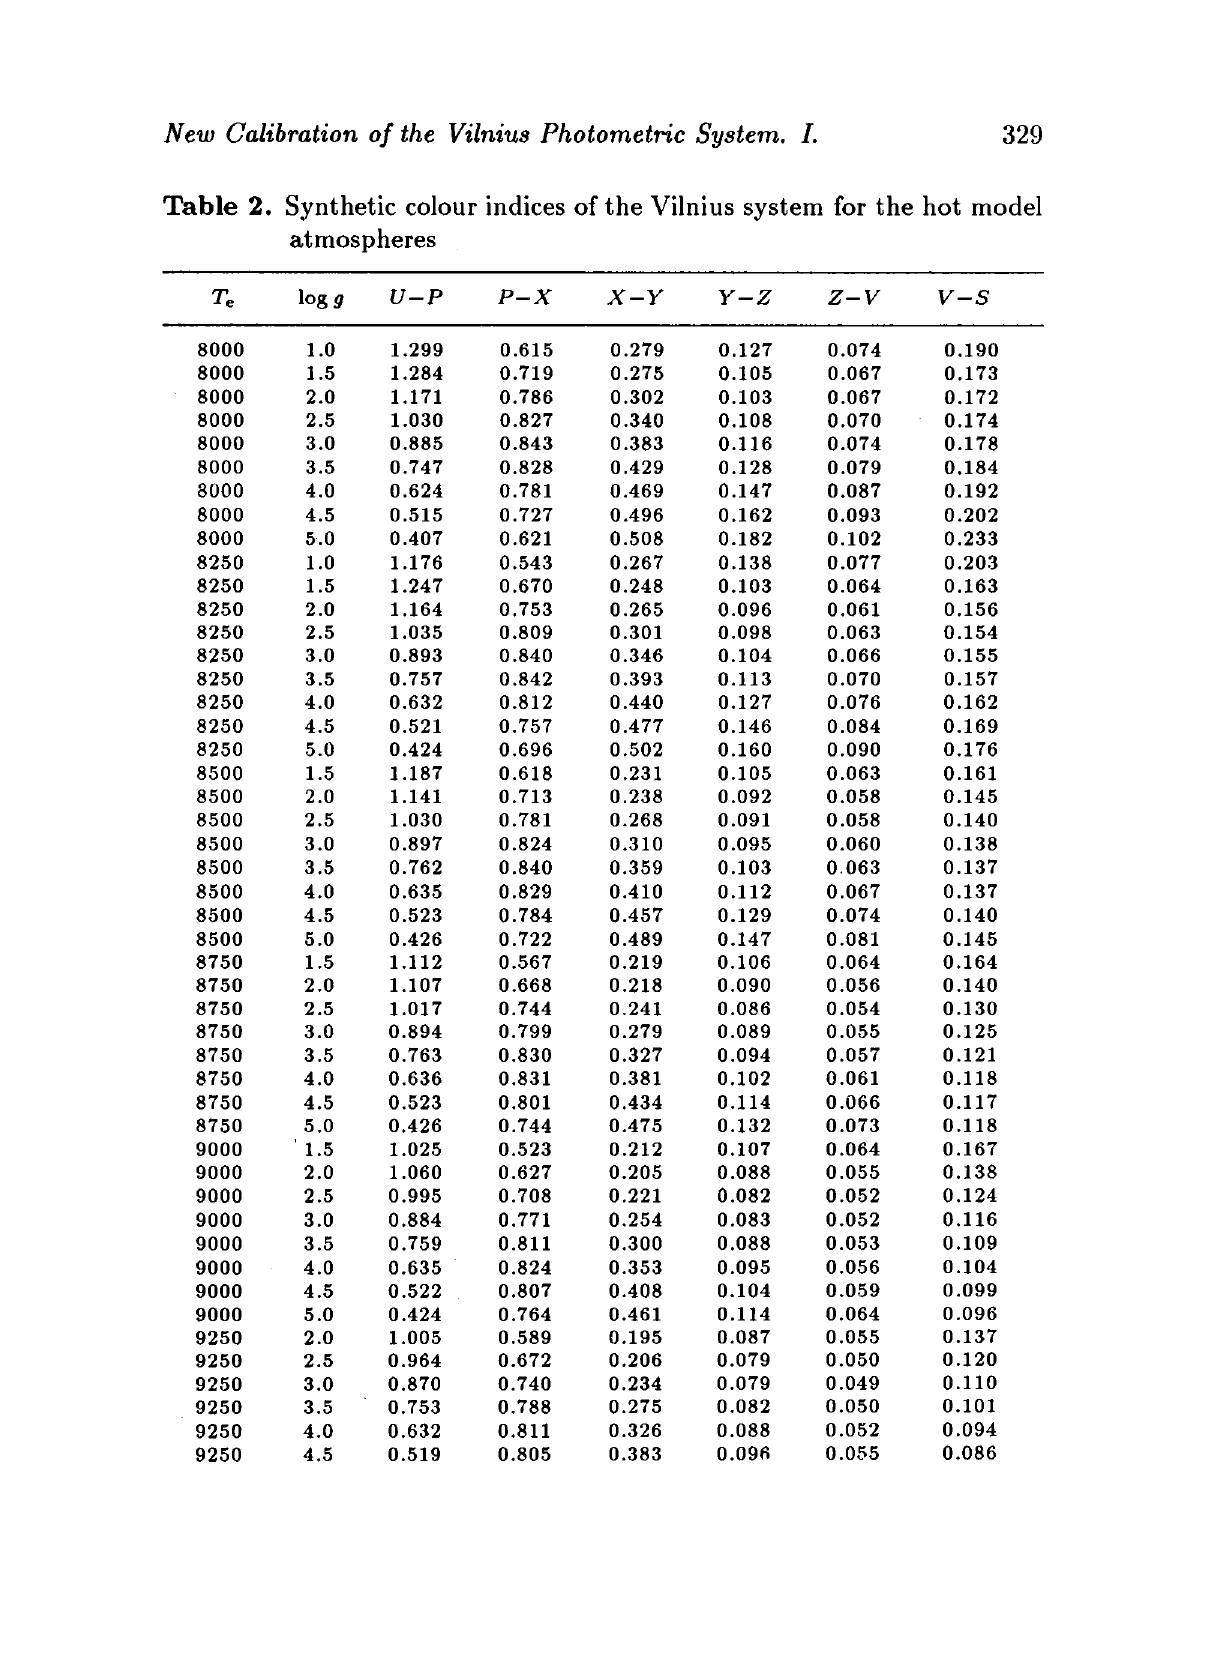
Table 2. Synthetic colour indices of the Vilnius system for the hot model